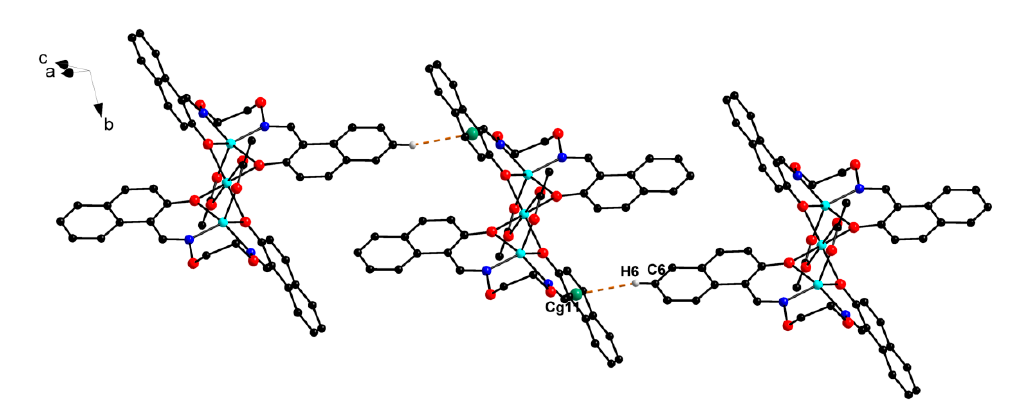
Figure 10. View of 1D supramolecular structure of the complex 2 showing the formation C-H··· π stacking interaction.